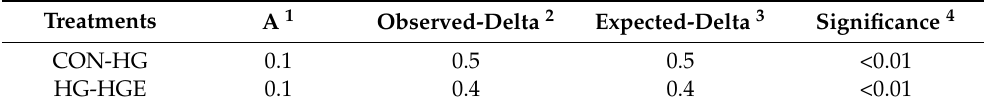
Table 10. Analysis of differences during MRPP.